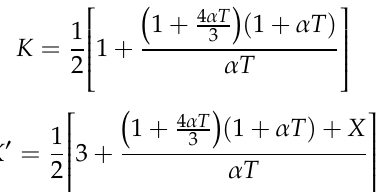
Figure 12. Plot of the values of pyrene in the aqueous solutions of ELP vs. log C